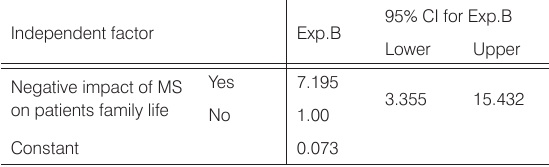
Table 3. Multiple logistic regression analysis of independent factors associated with depression.